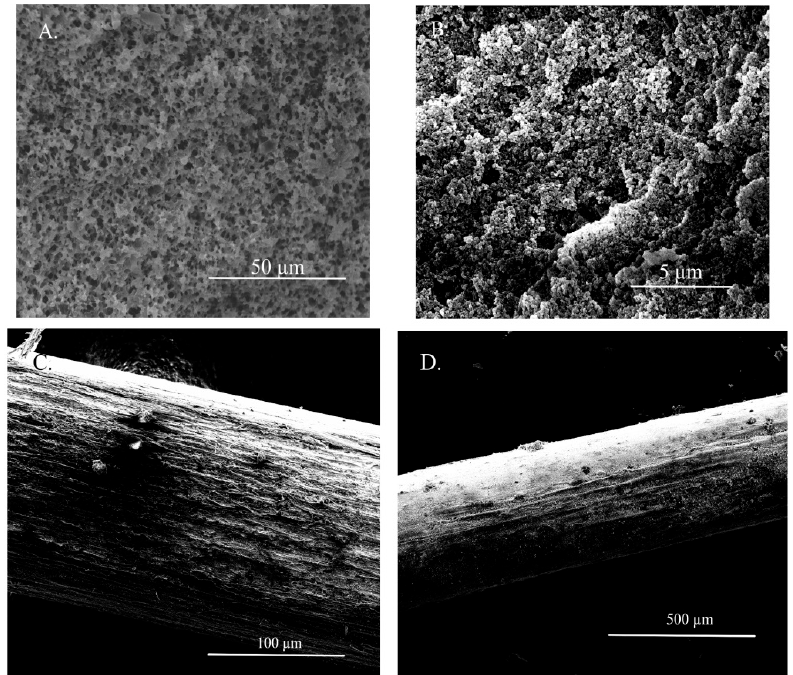
Figure 2. SEM images of the developed SPME fiber in different magnifications ( A ) 50 µ m; ( B ) 5 µ m; ( C ) 100 µ m; ( D ) 500 µ m.